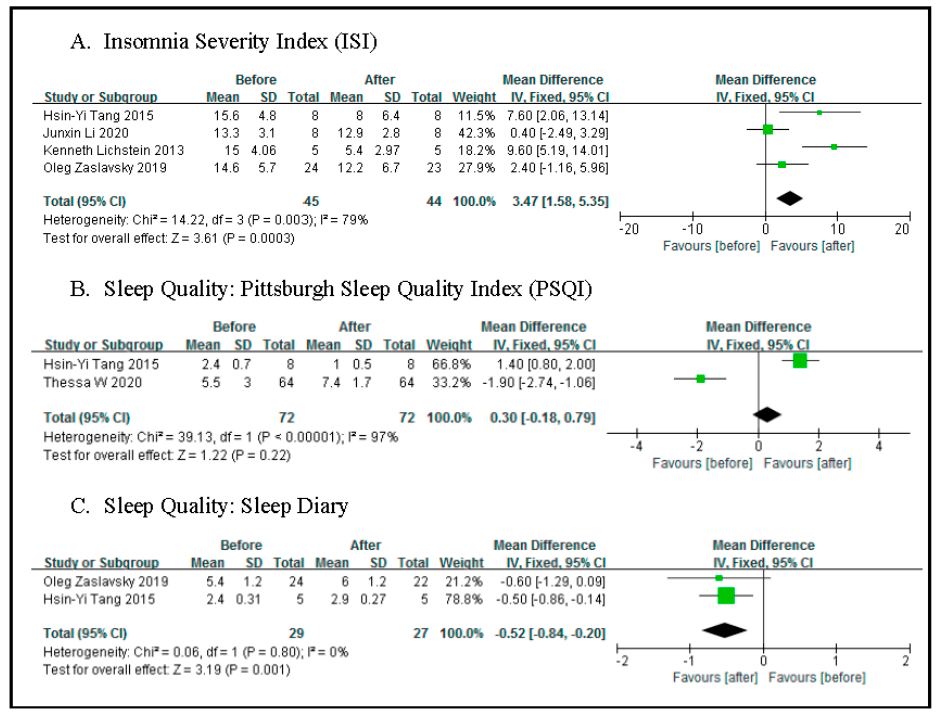
Figure 4. Meta-analysis of quasi-experimental studies.